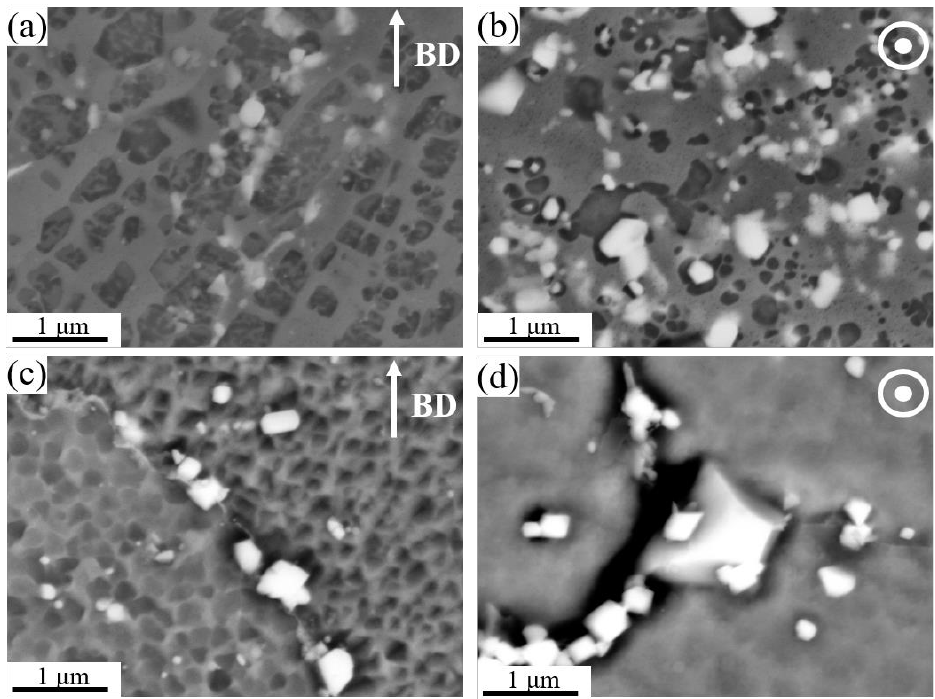
Figure 6. BSE images showing the microstructure after heat treatment of ( a ) the XZ plane of 13Co, ( b ) the XY plane of 13Co, ( c ) the XZ plane of 35Co, and ( d ) the XY plane of